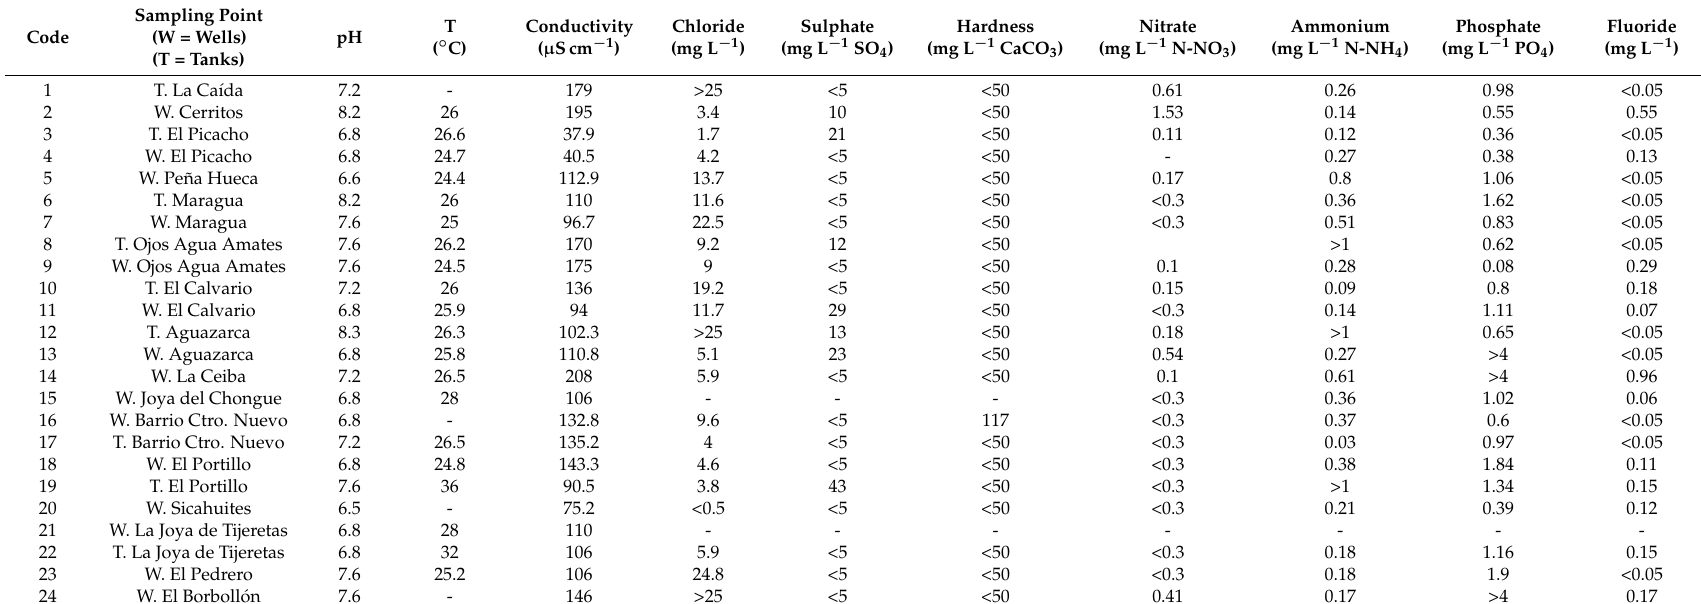
Table 3. Physicochemical parameters of the water samples (T: tank: W: